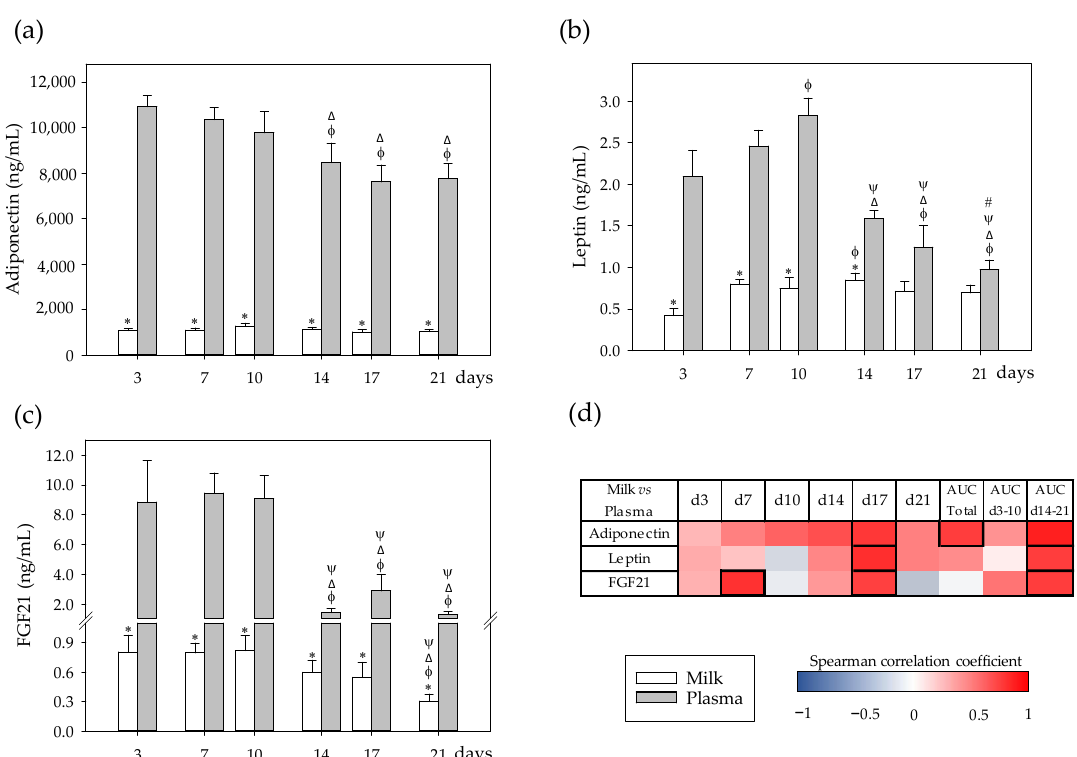
Figure 2. ( a ) Milk and plasma concentration of adipokines in dams: adiponectin, ( b ) leptin, and ( c ) fibroblast growth factor 21 (FGF21) throughout the lactation period. ( d ) Correlations between milk and plasma levels at specific days (3, 7, 10, 14, 17, and 21), while also considering their area under the curve during the whole lactation period (AUC total ), and AUC on the first (AUC d3–10 ) and the second period (AUC d14–21 ) of the study. The Spearman correlation coefficient is represented in the heat map following the color in the legend. Correlations with statistical significance ( p < 0.05) are shown in a bold frame. Statistical differences: * p < 0.05 vs. plasma on the same day; ϕ p < 0.05 vs. day 3, Δ p < 0.05 vs. day 7, ψ p < 0.05 vs. day 10, and # p < 0.05 vs. day 14 for the same type of sample ( N = 6–8).